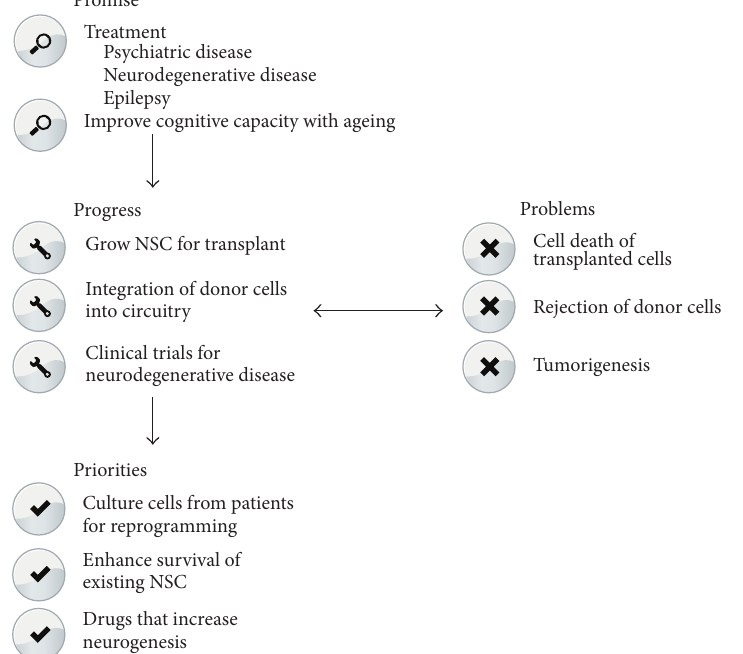
Figure 2: Summary of the promise, priorities, problems, and progress of the therapeutic application of NSCs. This schematic outlines the promise of the therapeutic application of NSCs, several of the priorities for applying NSCs for therapeutic application, some of the problems faced with using NSCs in patients, and finally what progress that has been made in the application of